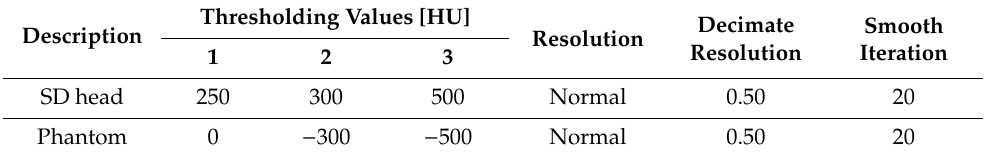
Table 2. Three-dimensional (3D) thresholding parameters for the SD head and the